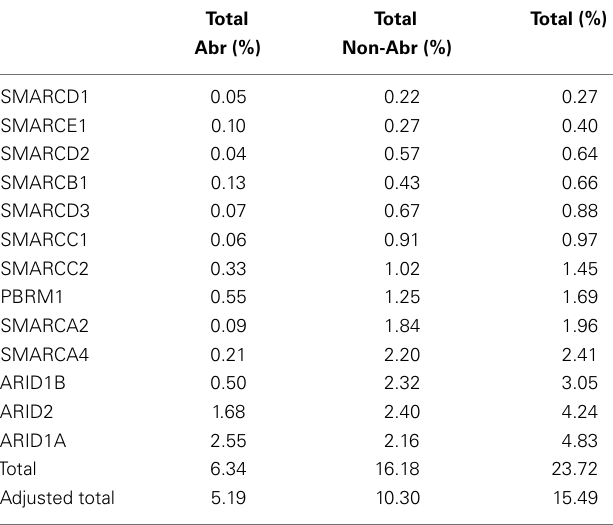
Table 1 |Weighted averaged mutations of SWI/SNF subunits